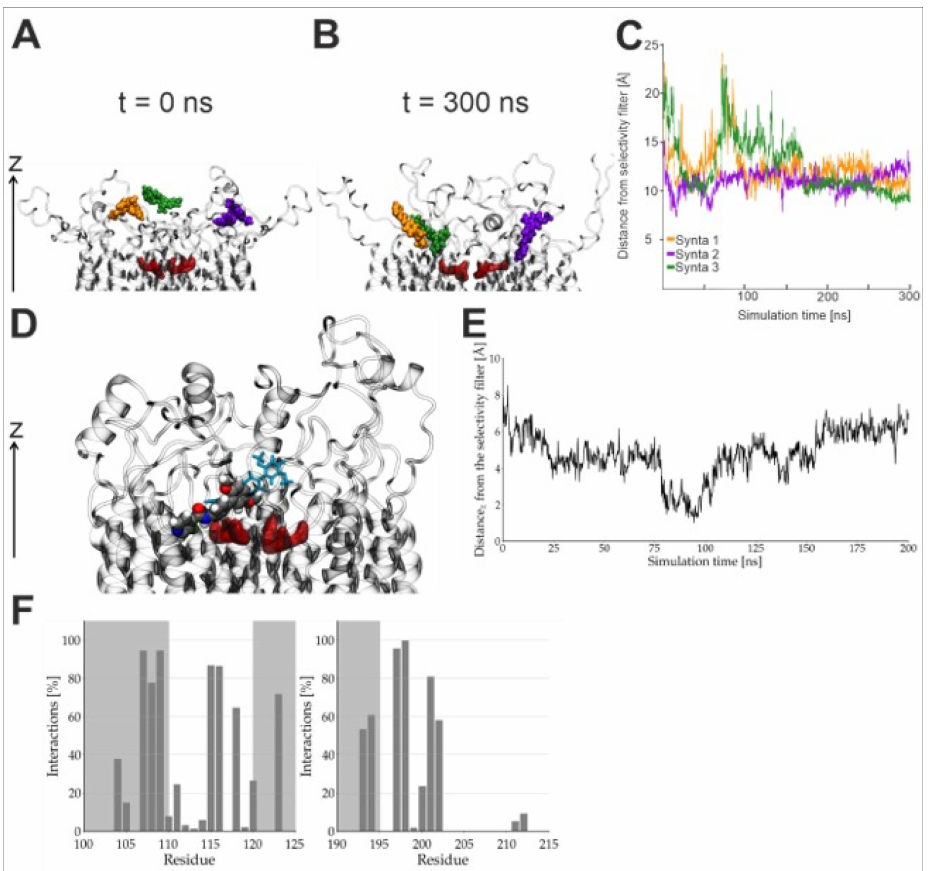
Figure 2. Interactions between free ligands with human Orai1: ( A , B ) Starting configuration ( A , t = 0 ns) and ( B ) MD simulations after 300 ns with three molecules of Synta66 present at the entry of the pore. The Orai channel protein is represented as a grey glassy ribbon with the selectivity filter highlighted in red. Individual molecules of Synta66 are represented in orange, violet and green. ( C ) Projection of the distance along the z-axis of the distances between the centre-of-mass of each molecule of Synta66 (colour code as in A , B ) and the selectivity filter as a function of the simulation time. ( D–E ) Molecular Dynamic (MD) simulations of a single docked Synta66 compound with start position of pose 1 (stick model) and after 200 ns of simulations (sphere model). ( e ) Projection of distances of a single Synta66 to the selectivity filter as in ( C ). ( F ) Interactions (in %) for a single Synta66 with Orai1